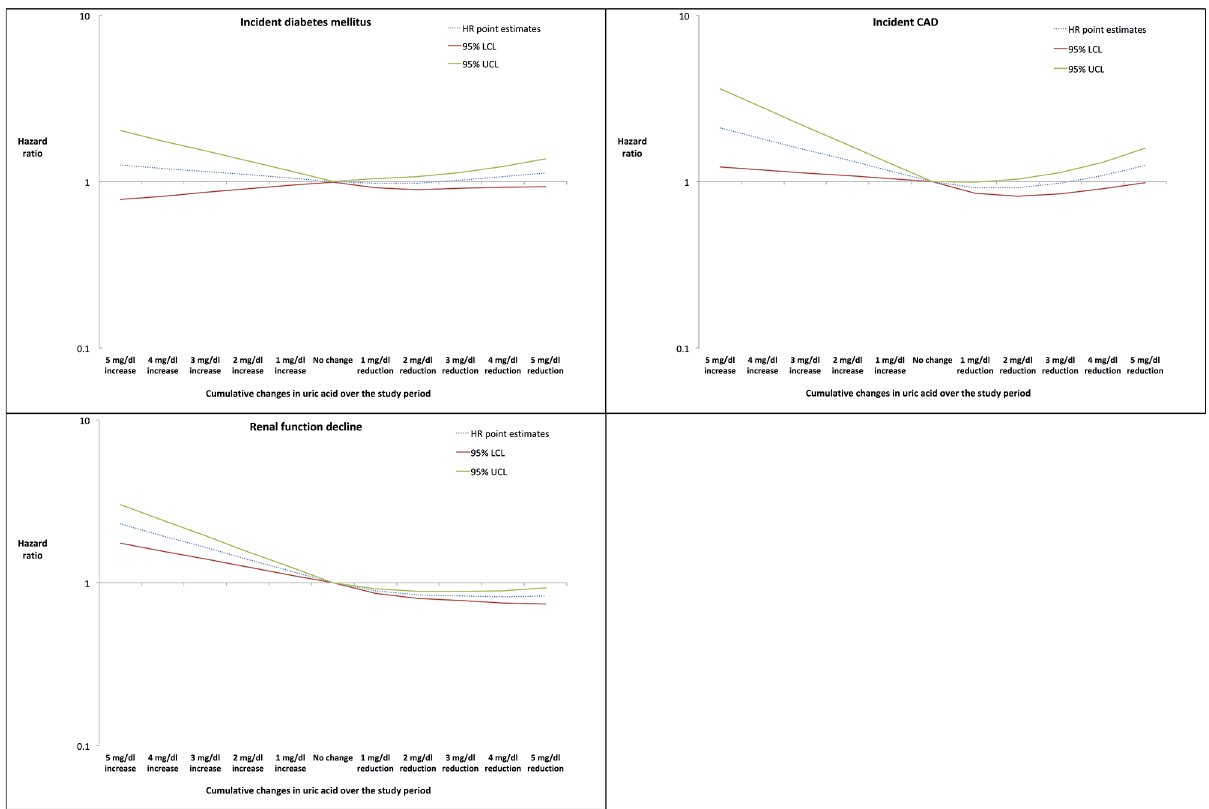
Fig 2. Association bewteen cumulative serum uric acid changes modeled as restricted cubic splines and cardiometabolic and renal outcomes in gout patients. Abbreviations: CVD- Cardiovascular disease, LCL- lower confidence limit, UCL- upper confidence limit.